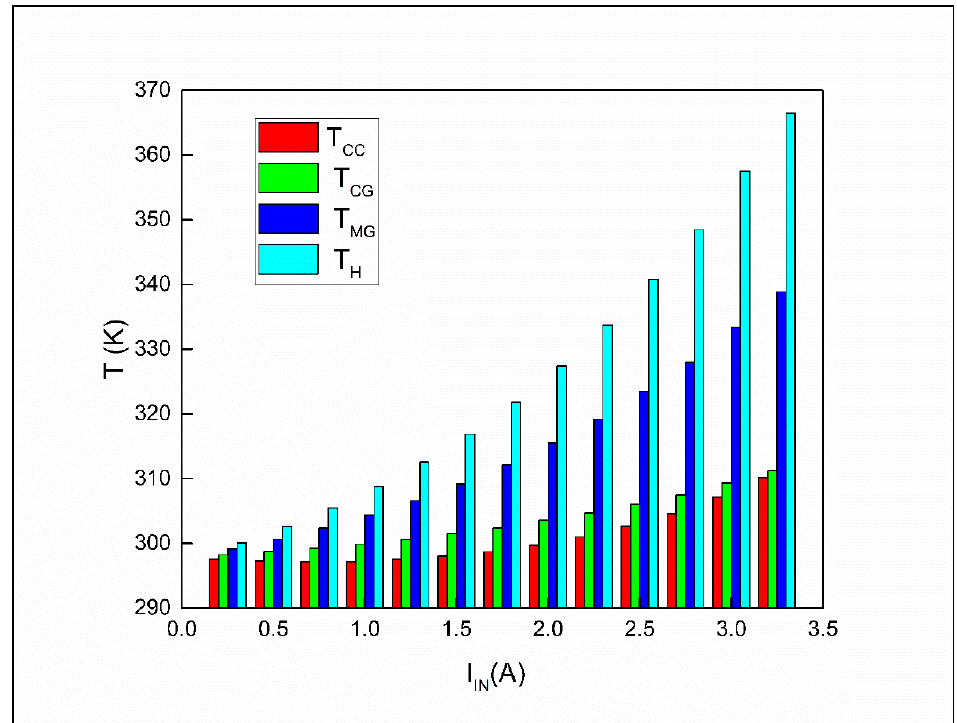
Figure 4. Dependence of IN V , load R on input current.